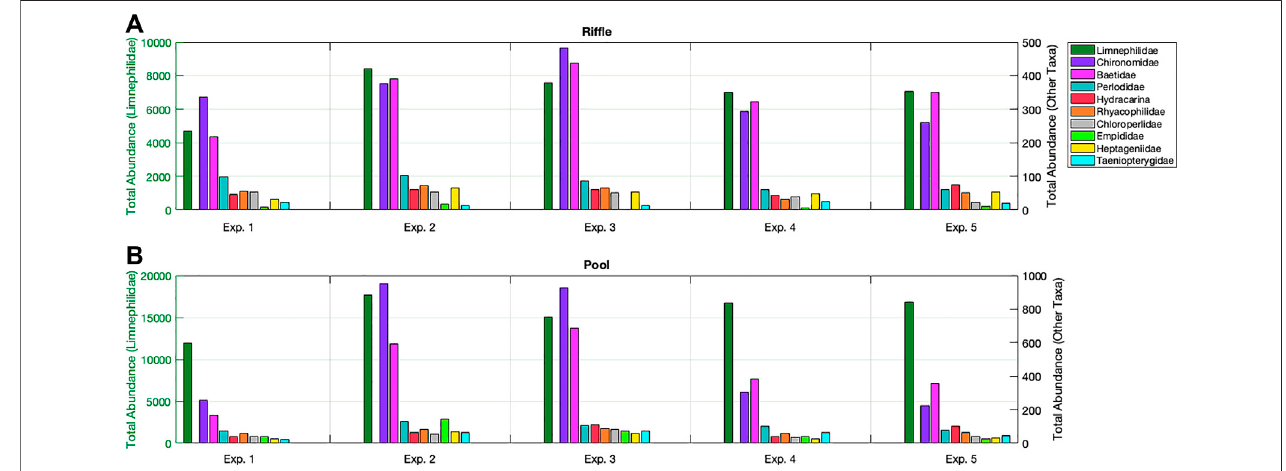
FIGURE 4 | Downstream rif fl e (A) vs. pool (B) : total abundance of the ten most common taxa, sum of all samples and nets for each experimental peak. The left y -axis is total abundance of Limnephilidae ( Drusus ssp.) and the right y -axis total abundance for all other taxa. The x -axis refers to the experimental peak.